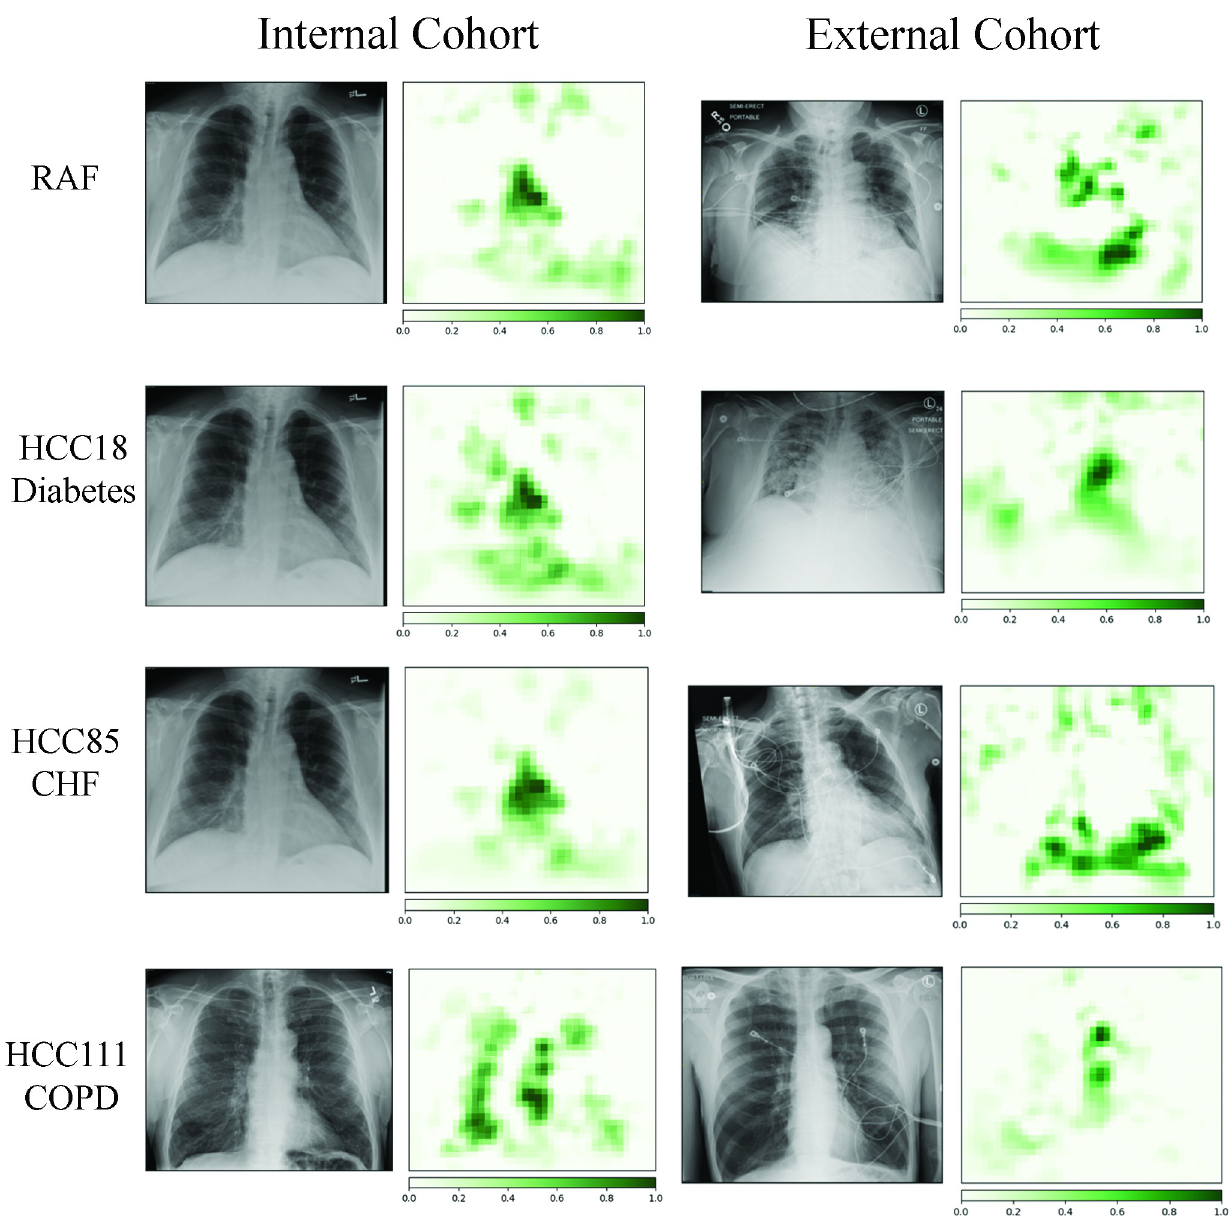
Fig 3. Green pixels indicate a location that when occluded changes the risk adjustment factor (RAF) score in top row. Each row represents the comorbidity and the resulting occlusion maps. Note that image labeling and electrodes do not impact the score. Please see discussion for further details. https://doi.org/10.1371/journal.pdig.0000057.g003 prediction (diabetes with chronic complications) (adjusted OR, 0.07; 95% CI: 0.009–0.59; P = .01) (Table 4). The AUC for this model was 0.76 (95% CI: 0.70–0.82). The model calibration had a slope of 0.92. Applying this logistic regression model on the combined internal valida- tion and external validation cohorts (n = 900) demonstrated an ROC AUC of 0.84 (95% CI: 0.79–0.88) for the prediction of mortality, indicating the model has generalizability. The ROC AUC of the internal validation cohort modeled similarly was 0.81 with a nonsensical confi- dence interval due to the low number of mortalities in the ambulatory cohort of patients.